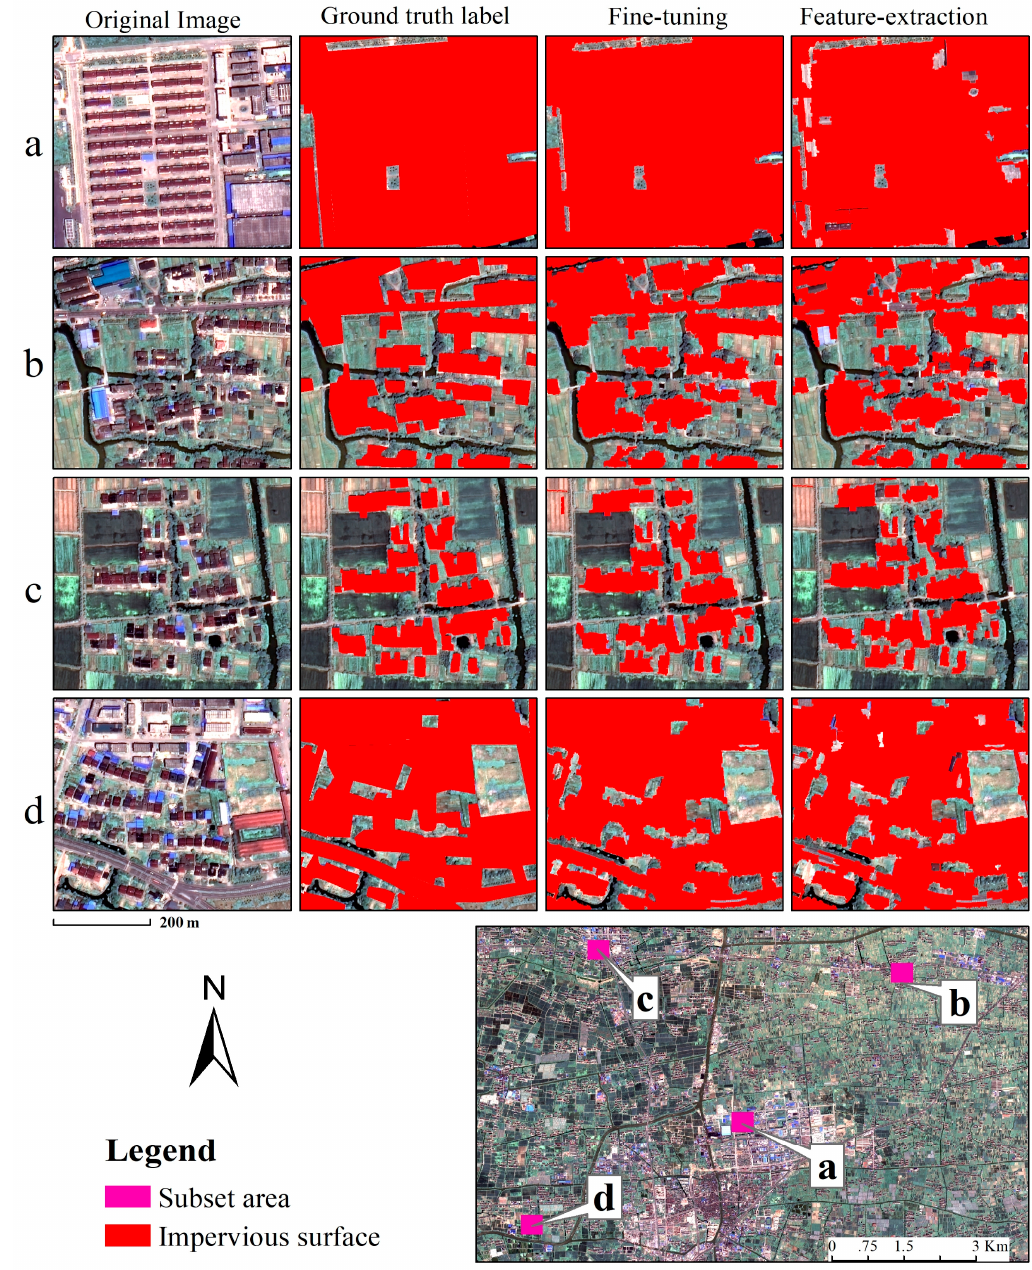
Figure 8. Subset examples from classification results using our proposed object-based deep convolution neural networks (CNNs).